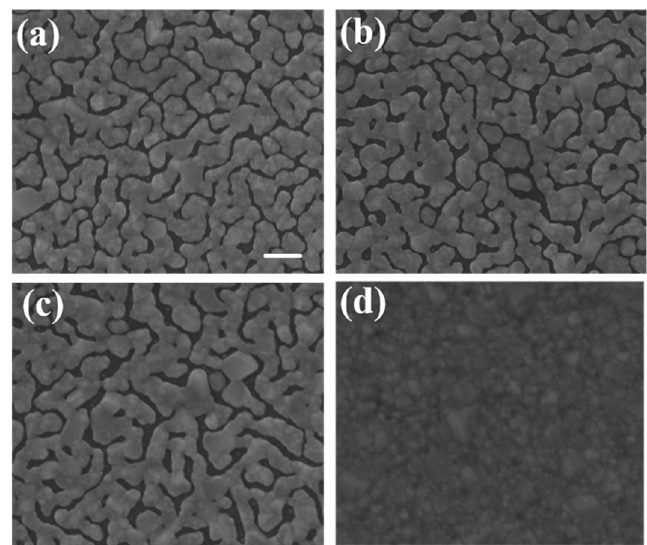
Figure 1. SEM images of sliver film with thickness of 30 nm deposited on flat substrate by thermal evaporation at rates of ( a ) 1.2 Å/s, ( b ) 2.4 Å/s, and ( c ) 3.6 Å/s, labeled as sample A, B, and C, respectively. ( d ) Flat silver film with thickness of 30 nm deposited by E-gun evaporation. Scale bar: 100 nm.